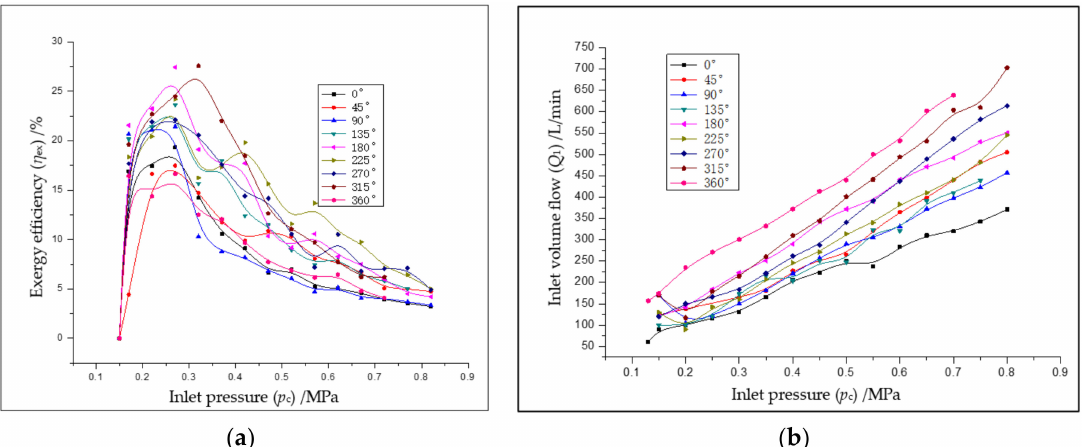
Figure 8. E ff ect of the cutting angle on the work performance: ( a ) e ff ect of cutting angle on exergy e ffi ciency; and ( b ) e ff ect of cutting angle on inlet